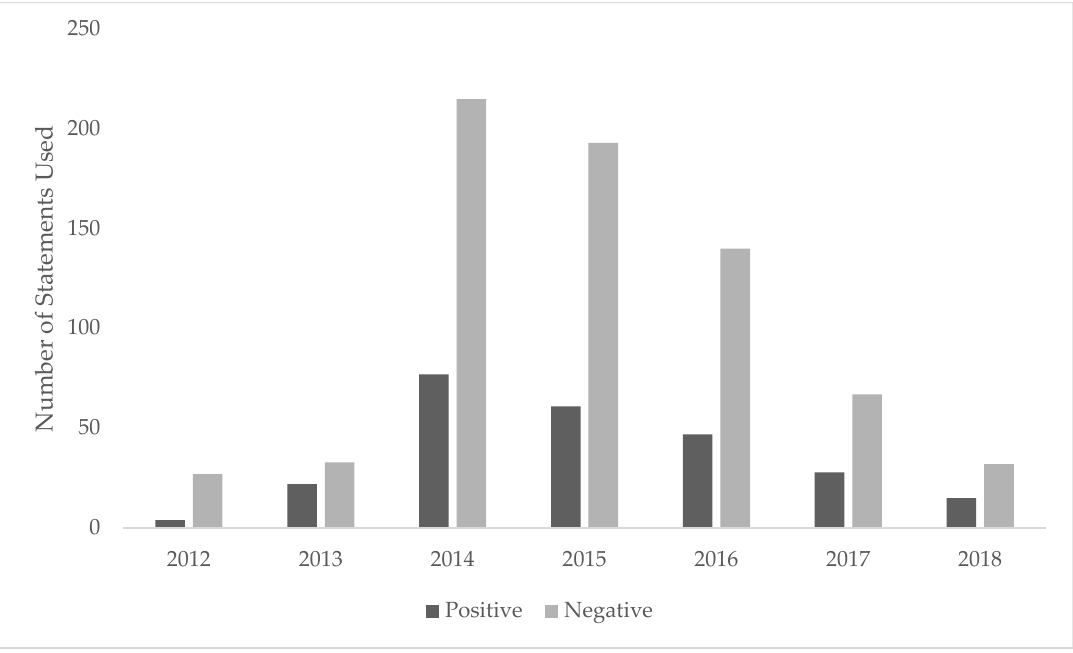
Figure 2. Number of positive and negative statements in electronic nicotine delivery system publications found in core clinical journals over time. Each specific statement was counted a maximum of one time per publication.